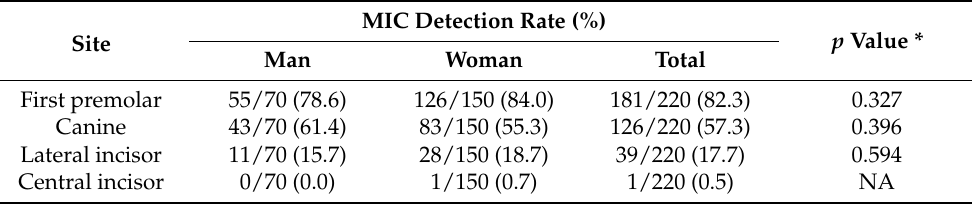
Table 1. The MIC detection rate at the four anatomical reference